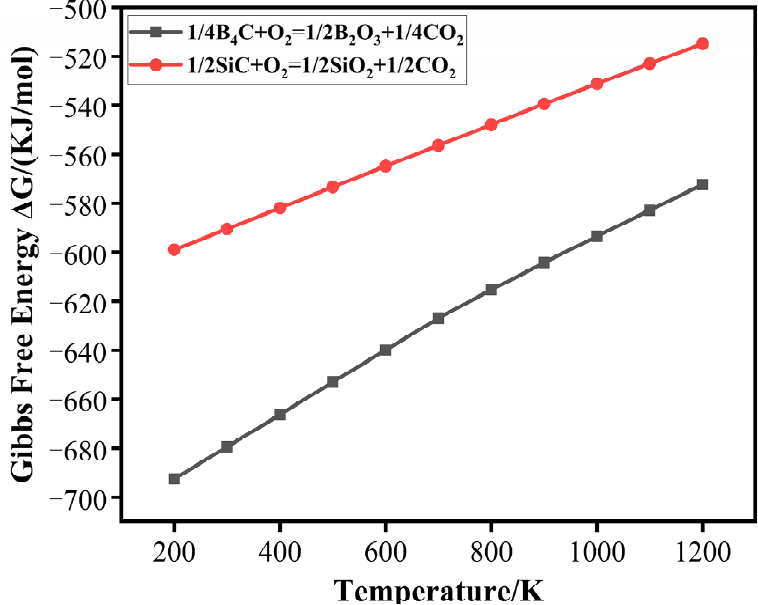
Figure 8. Standard Gibbs free energy of oxidation reaction of B 4 C and SiC.